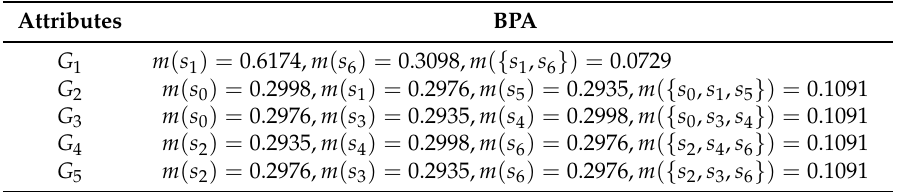
Table 15. BPAs of the attributes of A 4 .